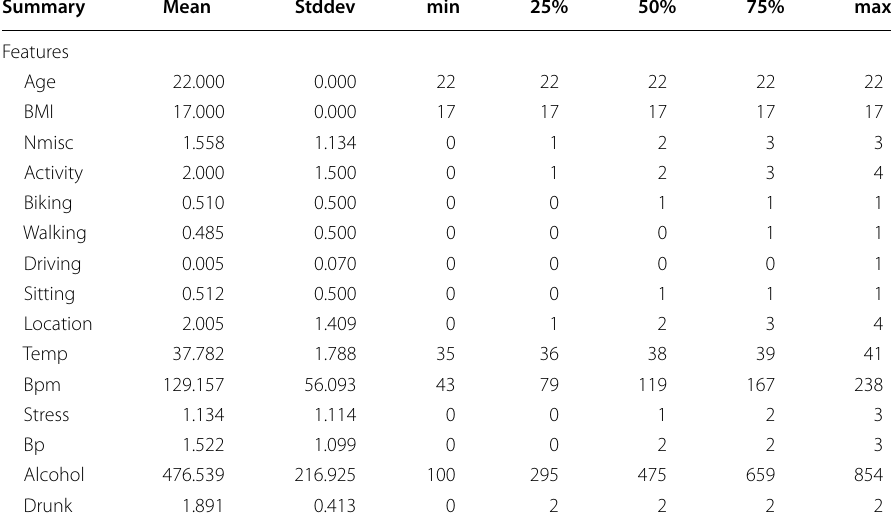
Table 7 Summary of